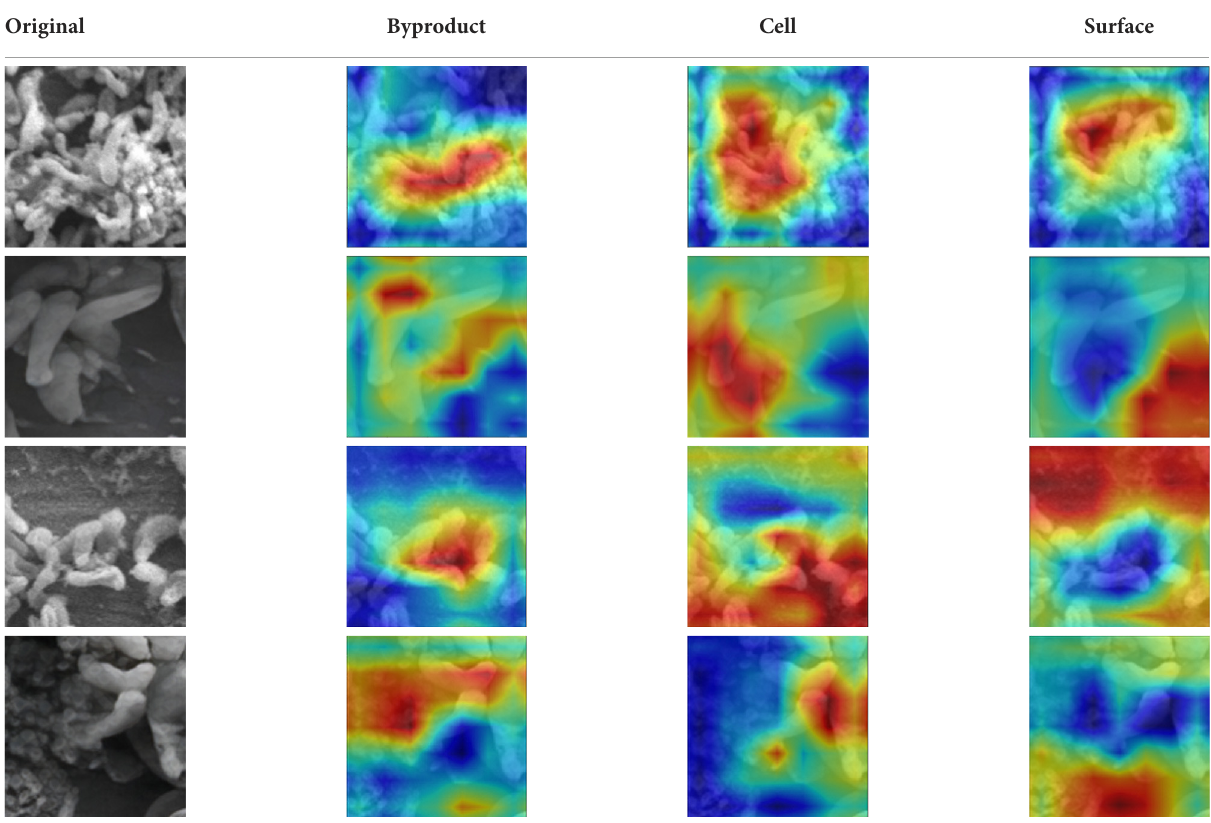
TABLE 3 CAM visualization